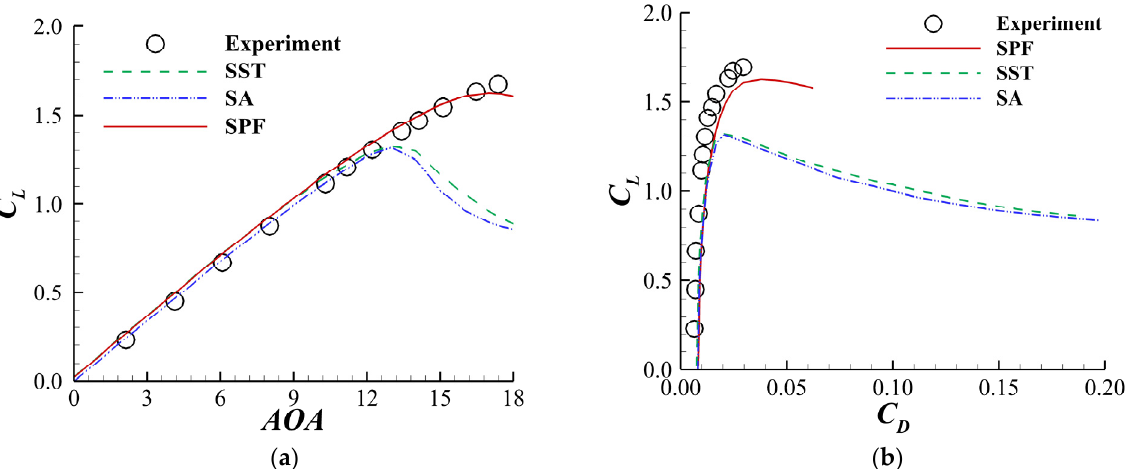
Figure 15. Aerodynamic characteristics of NACA0012 airfoil at large AOAs obtained by SST, SA and SPF with Re = 8.86 × 10 6 and Ma = 0.15. The circles are experimental data acquired by Gregory and Reilly [37]. ( a ) C L − AOA curve. ( b ) Lift–drag polar curve.